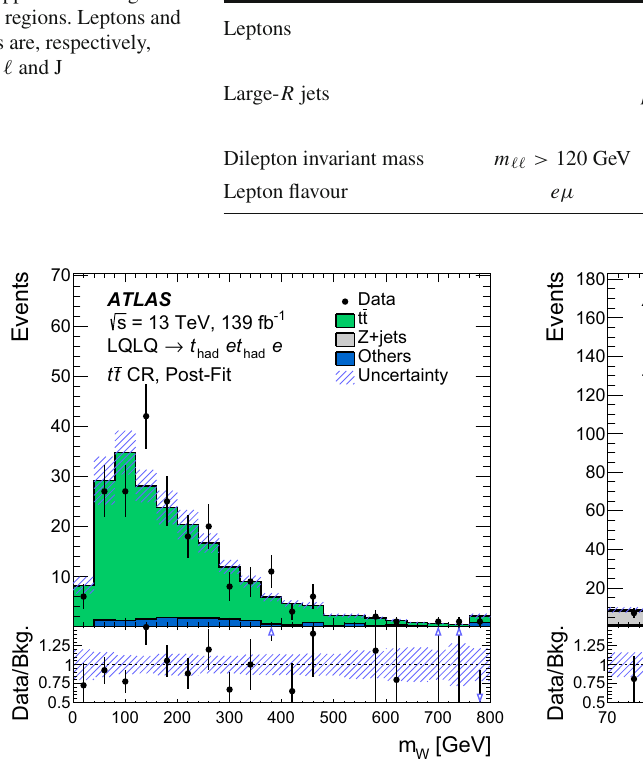
neousbackground-only fitofthemuonchannelCRs(right). Thebottom panels show the ratio of data to expected background. The hatched band represents the total uncertainty. The blue triangles indicate points that are outside the vertical